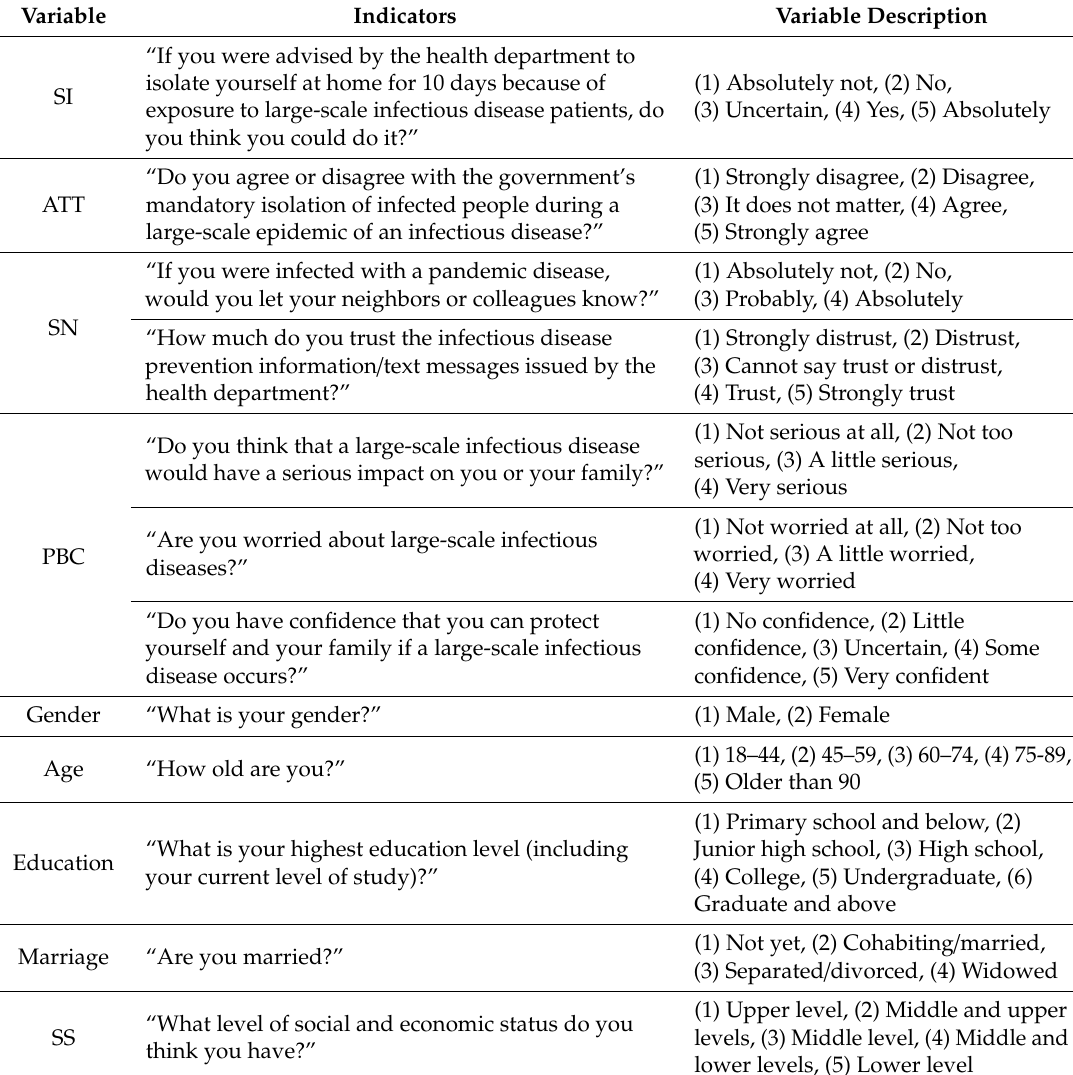
Table 1. Variable